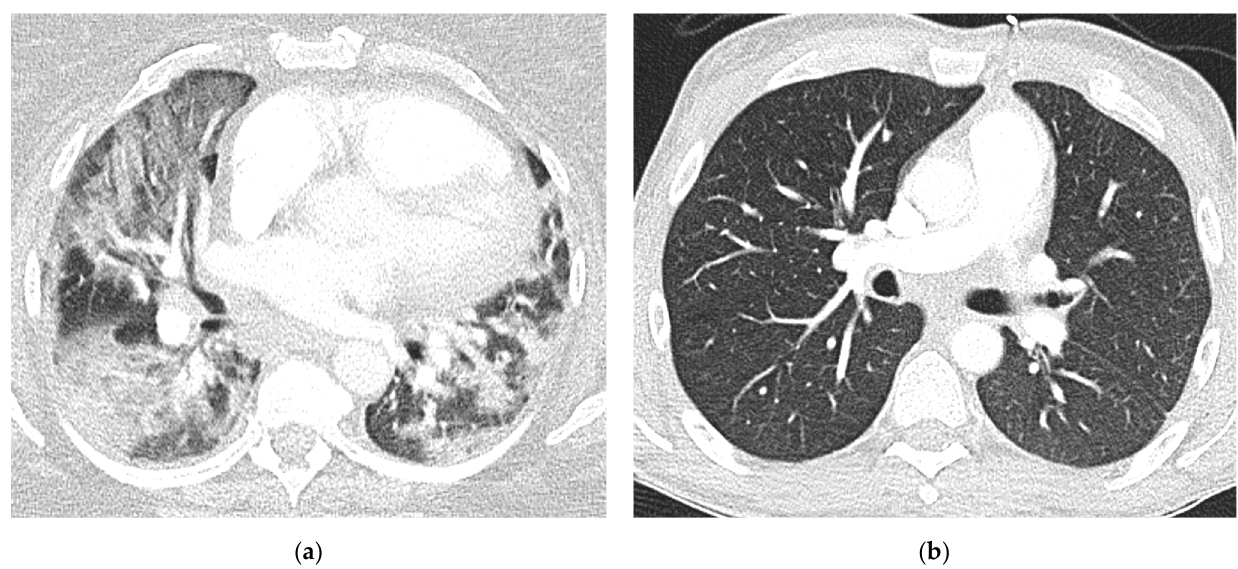
Figure 4. ( a ) A 54-year-old female patient with Delta variant with extensive lung involvement (semiquantitative score “15”); ( b ) a 40-year-old male patient with Omicron variant with “absence of pneumonia” (semiquantitative score